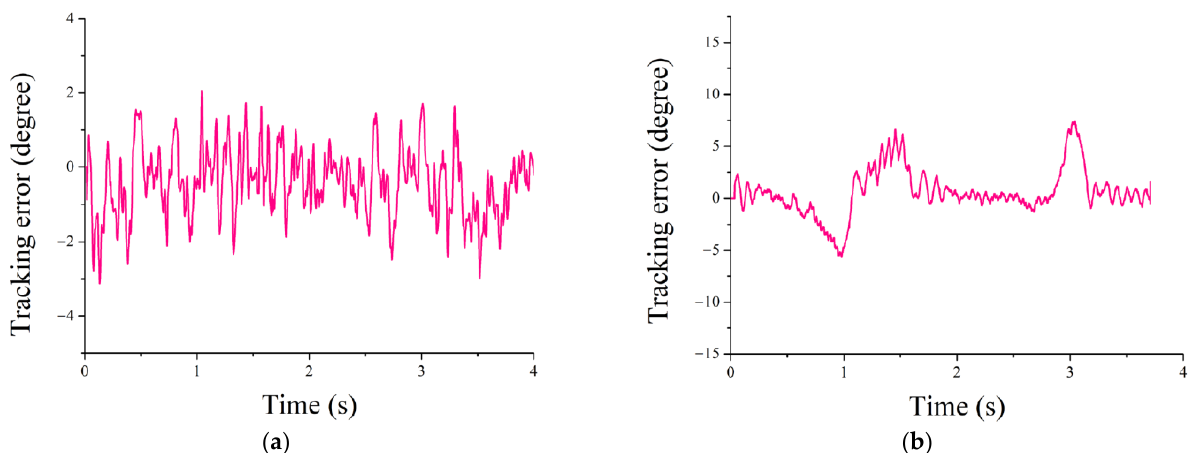
Figure 23. Tracking error of the ( a ) hip and ( b ) knee by the self-tuning controller.